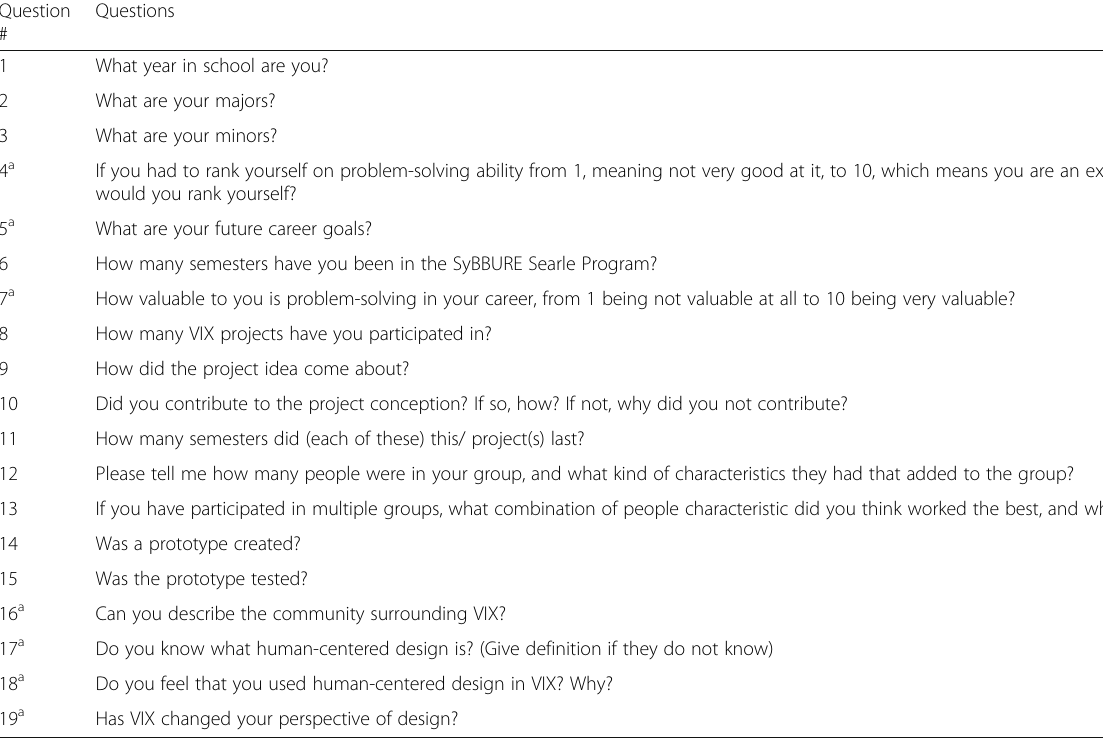
Table 1 Spring 2018 student interview